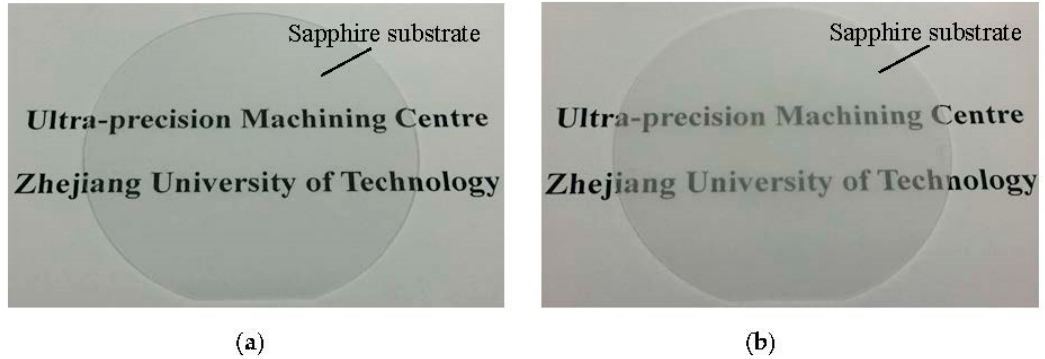
Figure 16. Sapphire substrates after polishing for 5 h with two polishing methods: ( a ) polished by DEPP and ( b ) polished by traditional